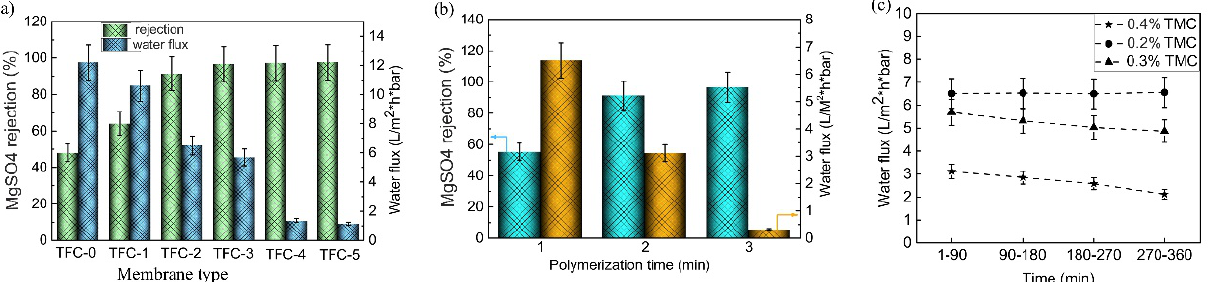
Figure 8. ( a ) Separation performance of the TFC membranes with different supports: ( b ) the effect of polymerization time on separation performance of the TFC membranes with support–3, MgSO 4 rejection (blue), and water flux (brown); ( c ) the effect of TMC concentration on permeate flux of the TFC membranes with support-3. Table 5. Comparison performance of fabricated TFC membrane with literature data.